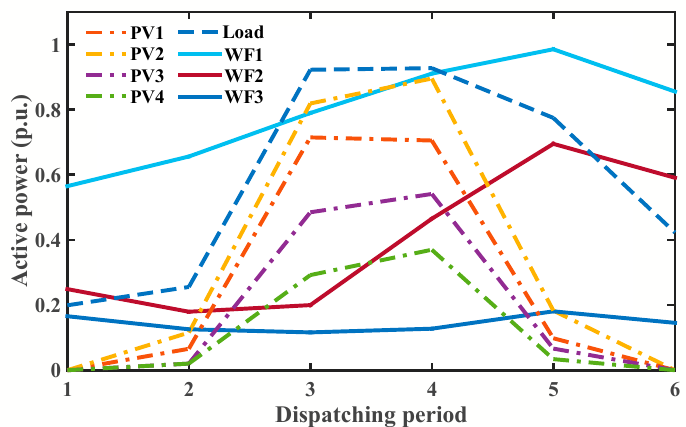
Figure 4. The typical output scenarios of WF and PV in di ff erent dispatching periods.